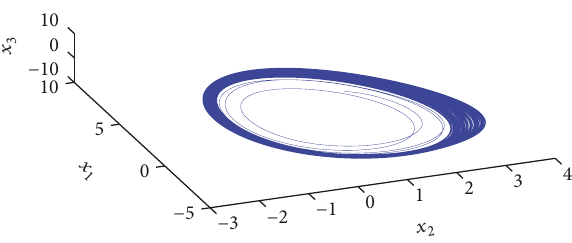
Figure 3: The phase trajectory of system